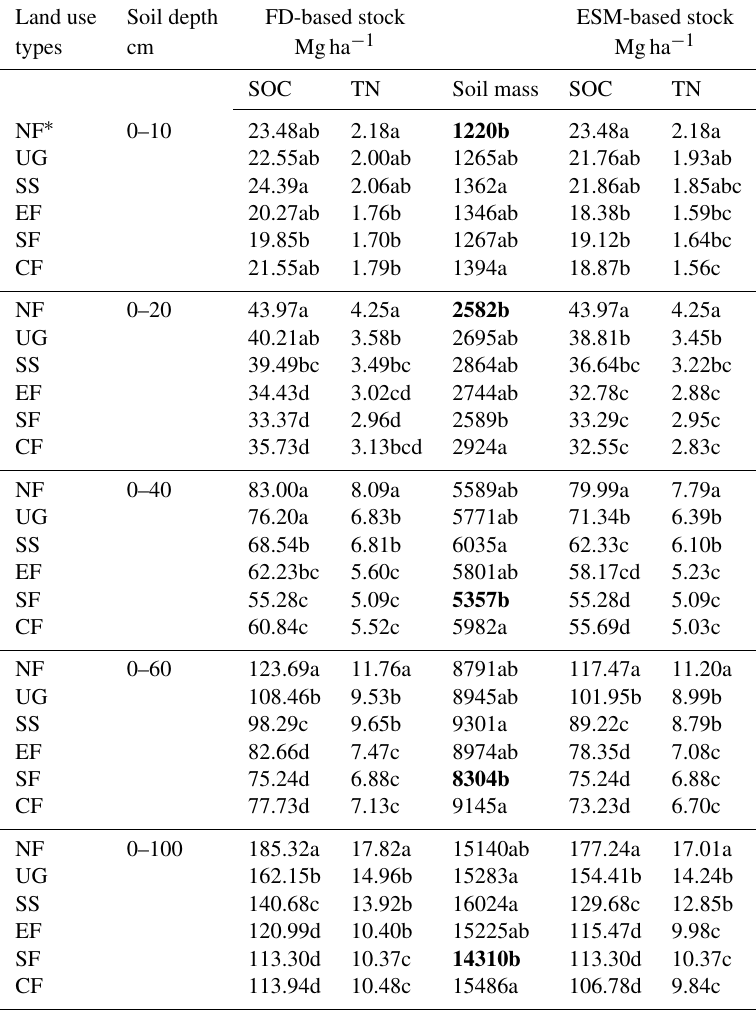
Table 4. Soil organic C (SOC) and total N (TN) stocks calculated using fixed-depth (FD) and equivalent soil mass (ESM) methods in different soil depths under land-uses types (NF, native forest; UG, unused grassland; SS, secondary shrub; EF, eucalyptus forest; SF, sugarcane field; CF, corn